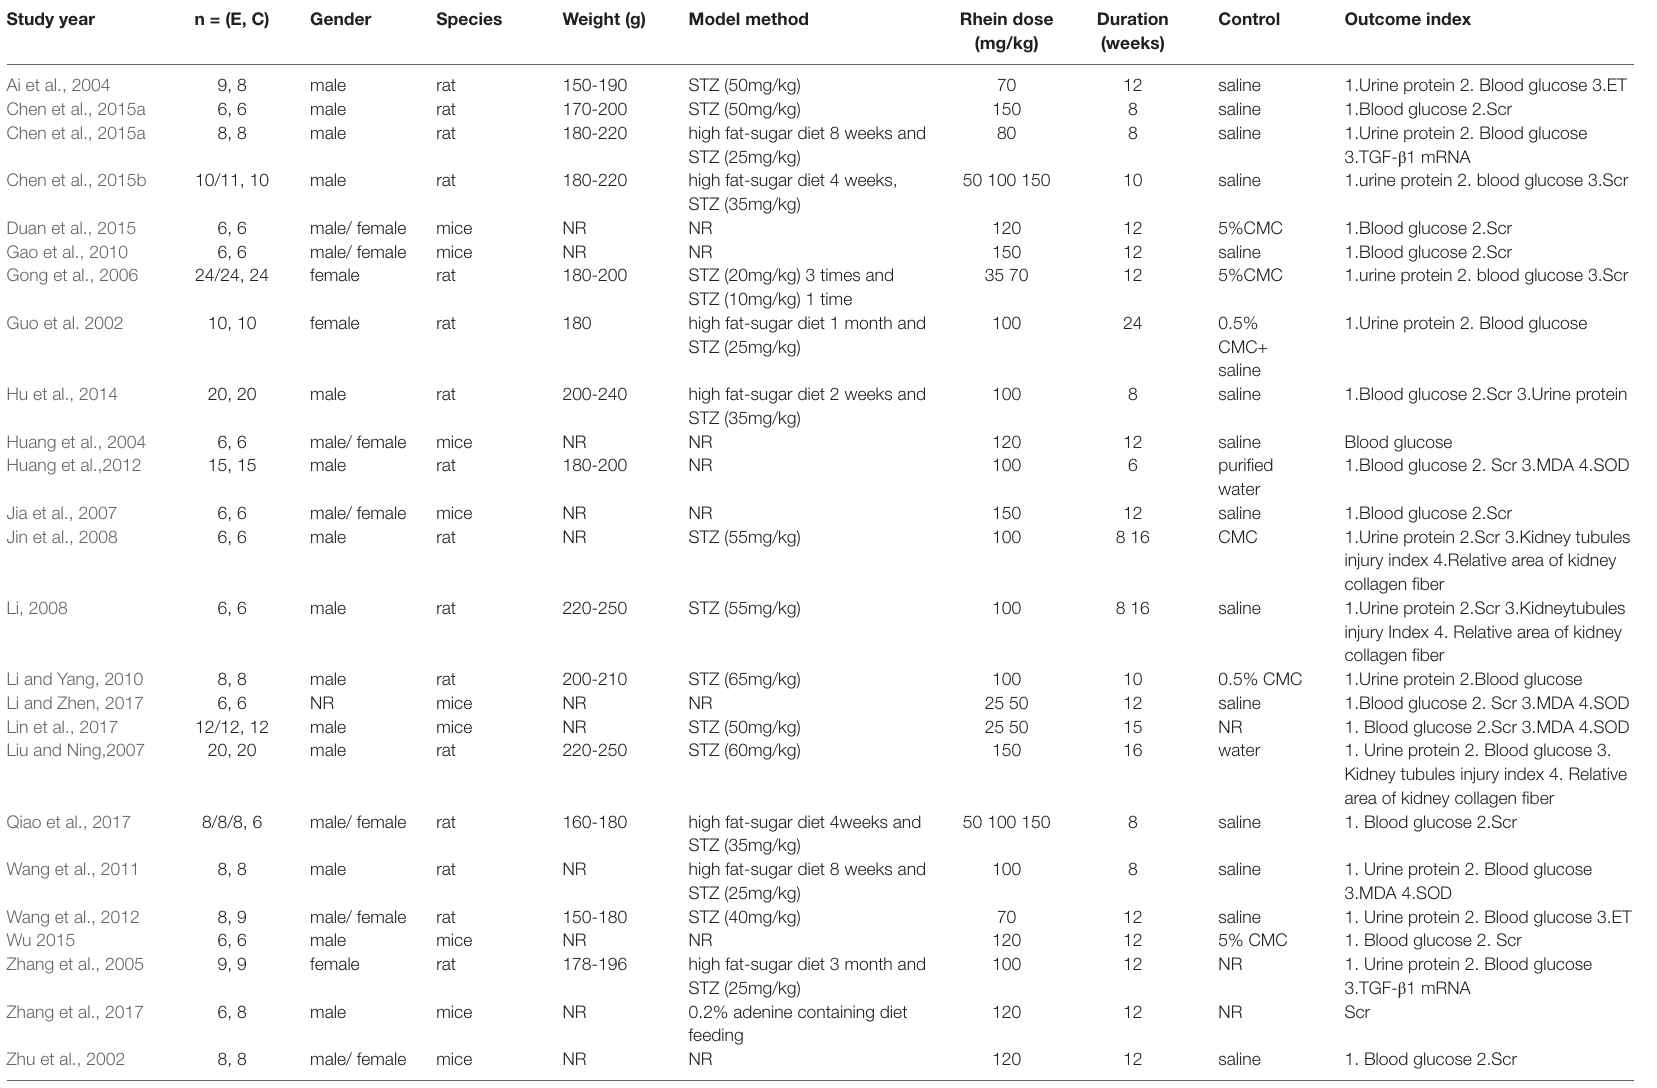
tABLe 1 | Characteristics of the included studies.